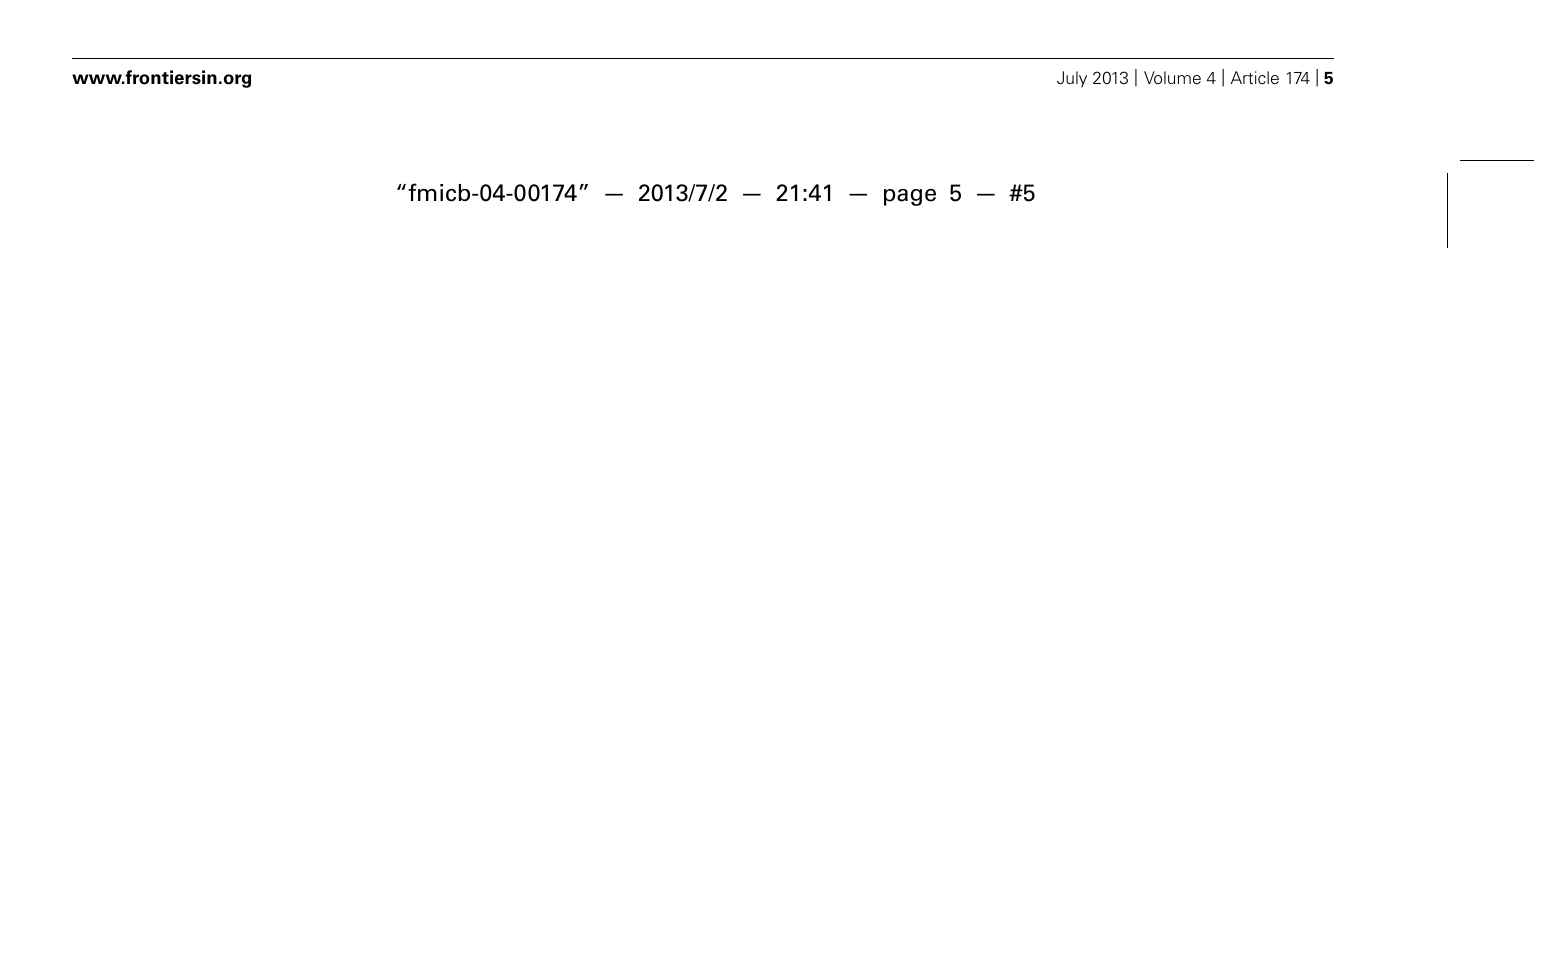
FIGURE 1 | Schematic representation of human HHV-6 receptor CD46, expressed in transgenic mice . CD46 consists of an extracellular part, with indicated binding site for different known CD46 ligands, transmembrane domain and one of two cytoplasmic tails: short, Cyt-1 or long, Cyt-2. MV, Measles Virus; AdV,